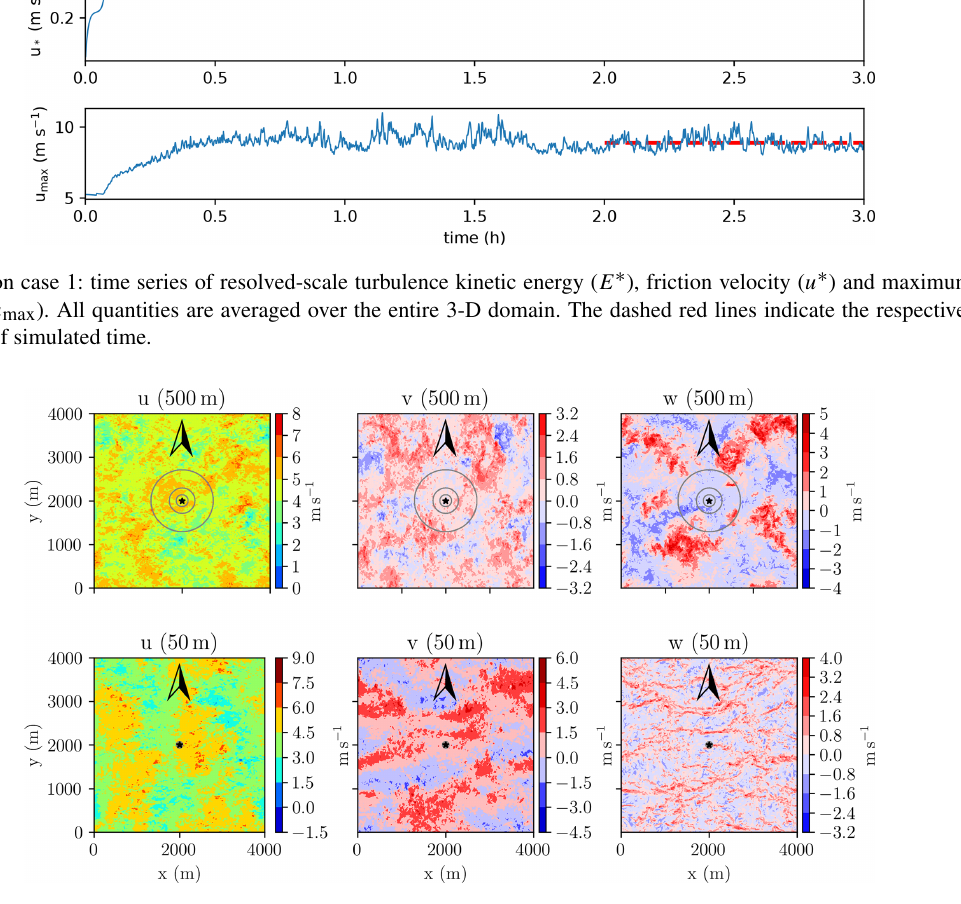
Figure 2. Simulation case 1: horizontal cross sections of instantaneous flow field components ( u , v , w ) at 2h simulation time, at 50m and at 500m height. The black star marks the location of the three virtual lidars, placed in the center of the domain. Each of the lidars is configured with a different zenith angle (15, 30, 54.7 ◦ ). Gray circles indicate the corresponding scanning circles at the respective height level. Arrows are pointing